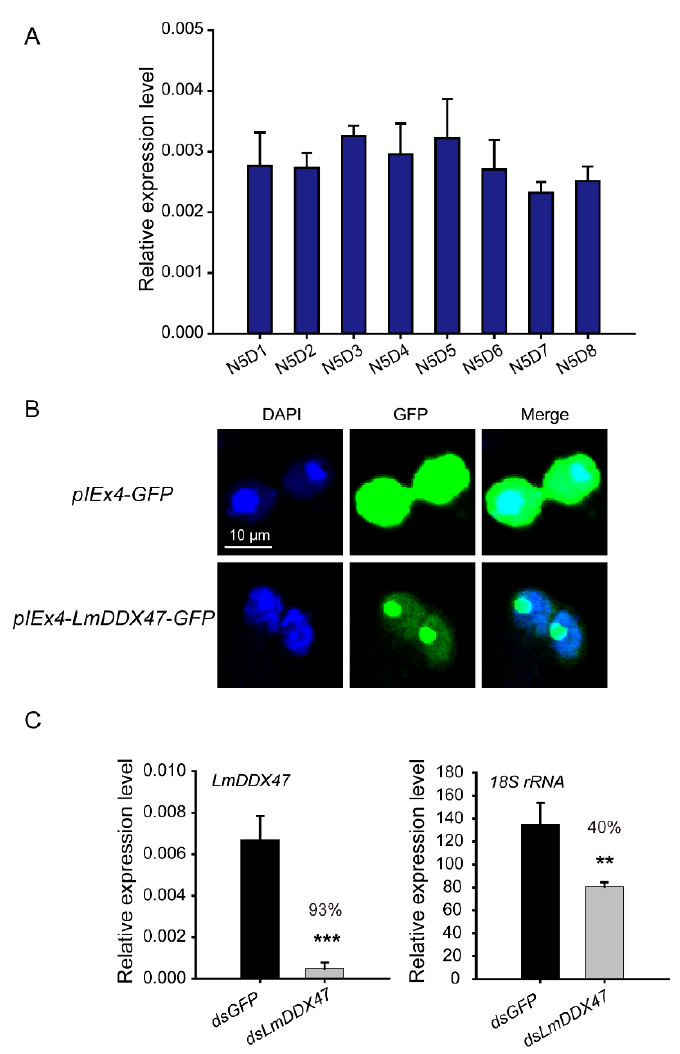
Figure 8. Relative expression of LmDDX47 in the midgut of fifth instar nymphs and its subcellular localization. ( A ) Relative expression of LmDDX47 in the midgut of fifth instar nymphs (N5D1–N5D8) by qRT-PCR. RPL32 was used as the reference gene. All data are presented as mean ± SD of five independent biological replicates. ( B ) Subcellular localization of LmDDX47 detected by transient transfection with the pIEx4 - LmDDX47 - GFP construct in Drosophila S2 cells. Transfection with the pIEx4 - GFP vector was the control. Blue indicates the nucleus, and green represents GFP expression. ( C ) Expression of 18S rRNA and LmDDX47 was detected in the midgut of N5D7 nymphs after LmDDX47 RNAi. RPL32 was used as the reference gene. All data are presented as means ± SD of six independent biological replicates. ** p < 0.01; *** p < 0.001.